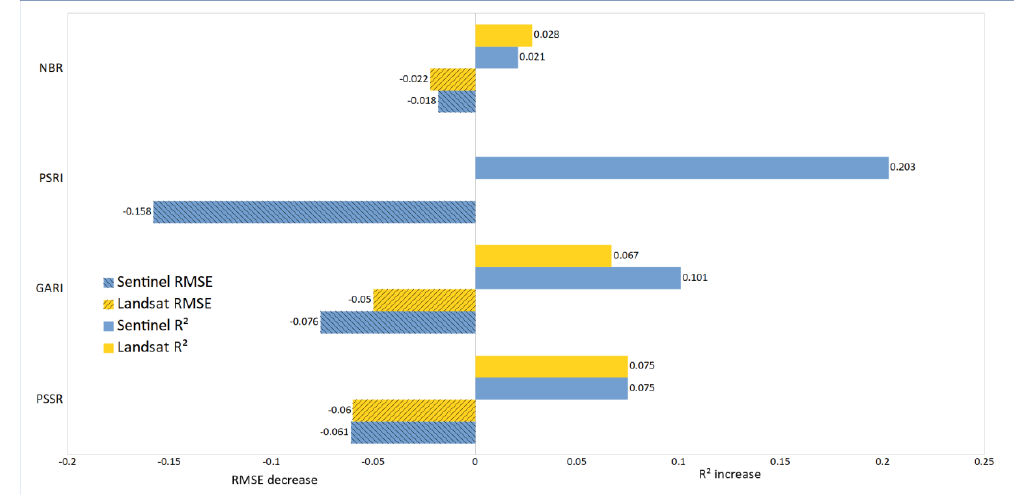
Figure 5. Effect of changing pixel window size from 10 m to 60 m on LAI e model RMSE and R 2 for the best-performing Landsat-8 and Sentinel-2 vegetation indices.